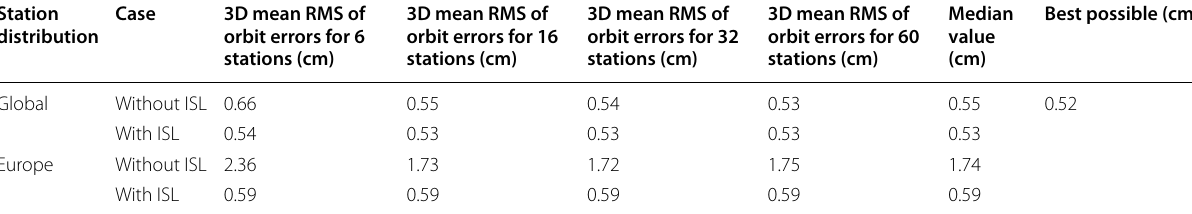
Table 6 3D mean RMS of orbit errors for the networks with different number of stations Station Case 3D mean RMS of 3D mean RMS of distribution orbit errors for 6 orbit errors for 16 stations (cm) Global Without ISL 0.66 Europe Without ISL 2.36